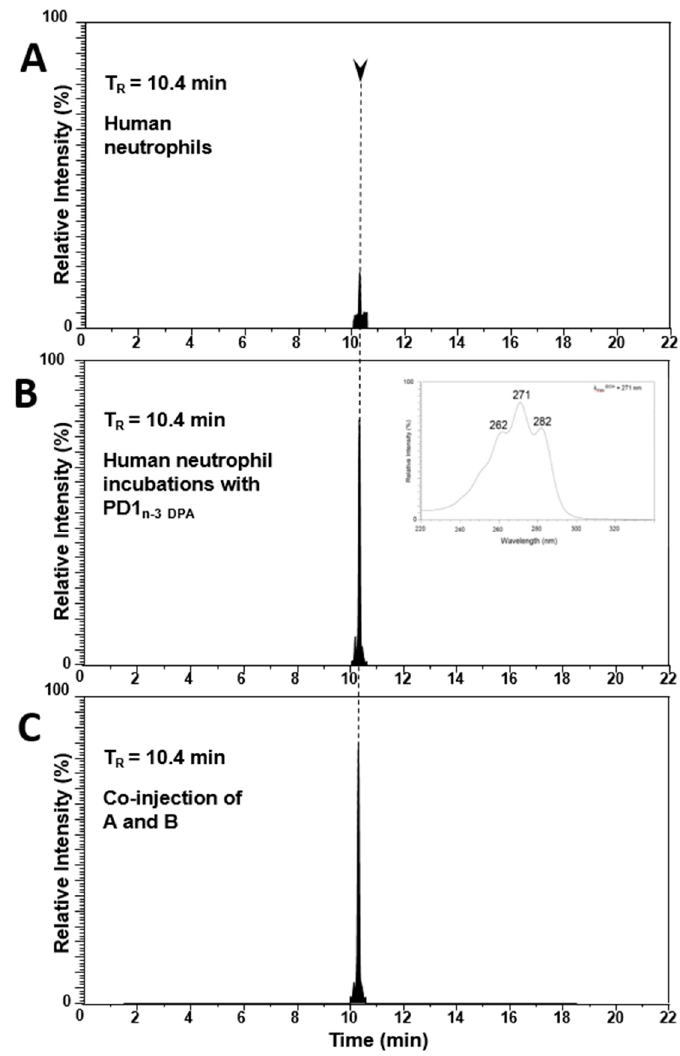
Figure 4. MRM chromatogram of the products from ( A ) human neutrophils incubated with vehicle; ( B ) human neutrophils incubated with PD1 n-3 DPA ( 2 ); ( C ) co-injection of samples obtained from ( A ) and ( B ).